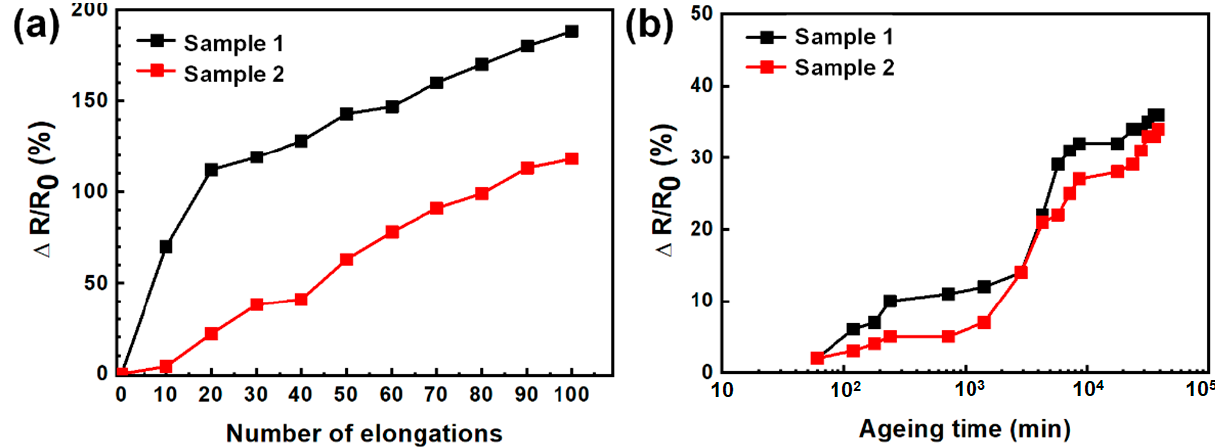
Figure 5. Sheet resistance variation of E-textiles under stretching ( a ) and ageing test ( b ). To enable the practical use of the E-textiles, it should be able to endure the washing process. As shown in Figure 6a, we simply assessed the washing reliability of the E-textiles by immersing the samples in deionized water with a stirring at 1500 rpm for 30 min. The textiles were then dried by heat gun for 3 min between each washing cycle. The sheet resistance increased to 120% and 135 % for sample 1 and sample 2, respectively, after four washing cycles. (Figure 6b) The increase in the sheet resistance may have been due to oxidation of the PEDOT chain as the samples were contacted with water molecules. The sheet resistance increase of sample 2 was higher than sample 1, which would be due to the larger surface area of the PEDOT:PSS film in the E-textiles. As such, it is suspected that the PEDOT:PSS of sample 2 would dissolve or collapse upon contact with water, as the electrical conductivity is greatly reduced as compared to sample 1, which has an adverse effect on the practical use of the E-textile